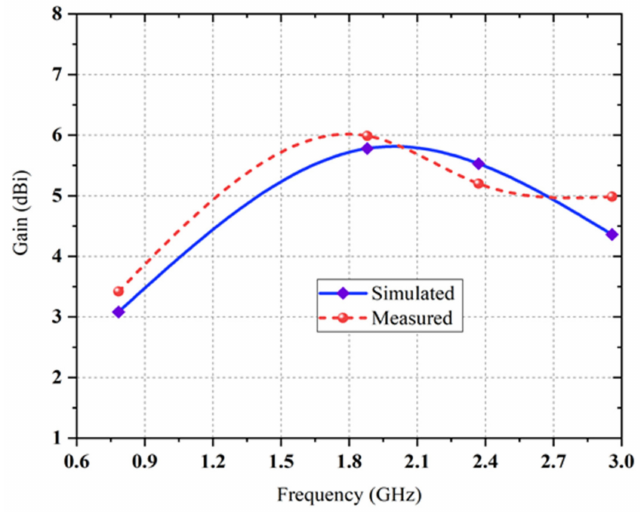
Figure 8. The comparison between simulated and measured peak realized gain of the proposed